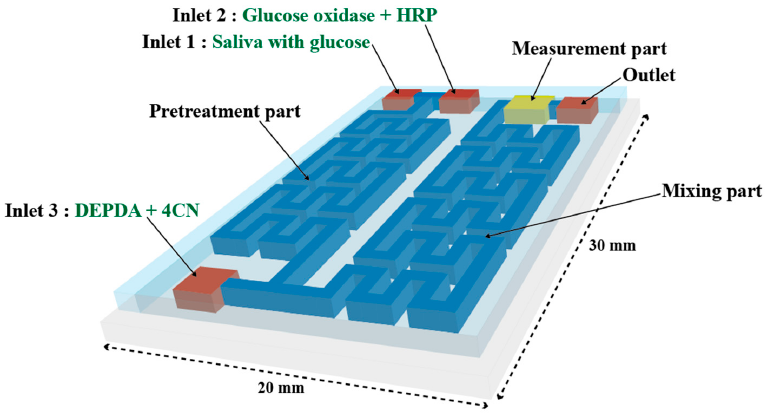
Figure 2. Schematic of the proposed lab-on-a-chip (LOC)-based non-invasive optical sensor for measuring glucose in saliva.